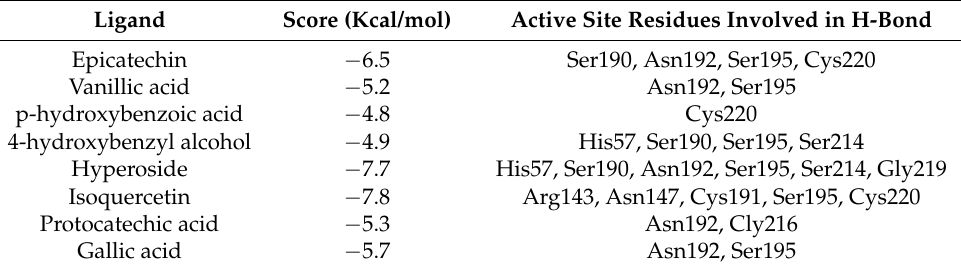
Table 5. Docking score and binding sites of the different ligands with